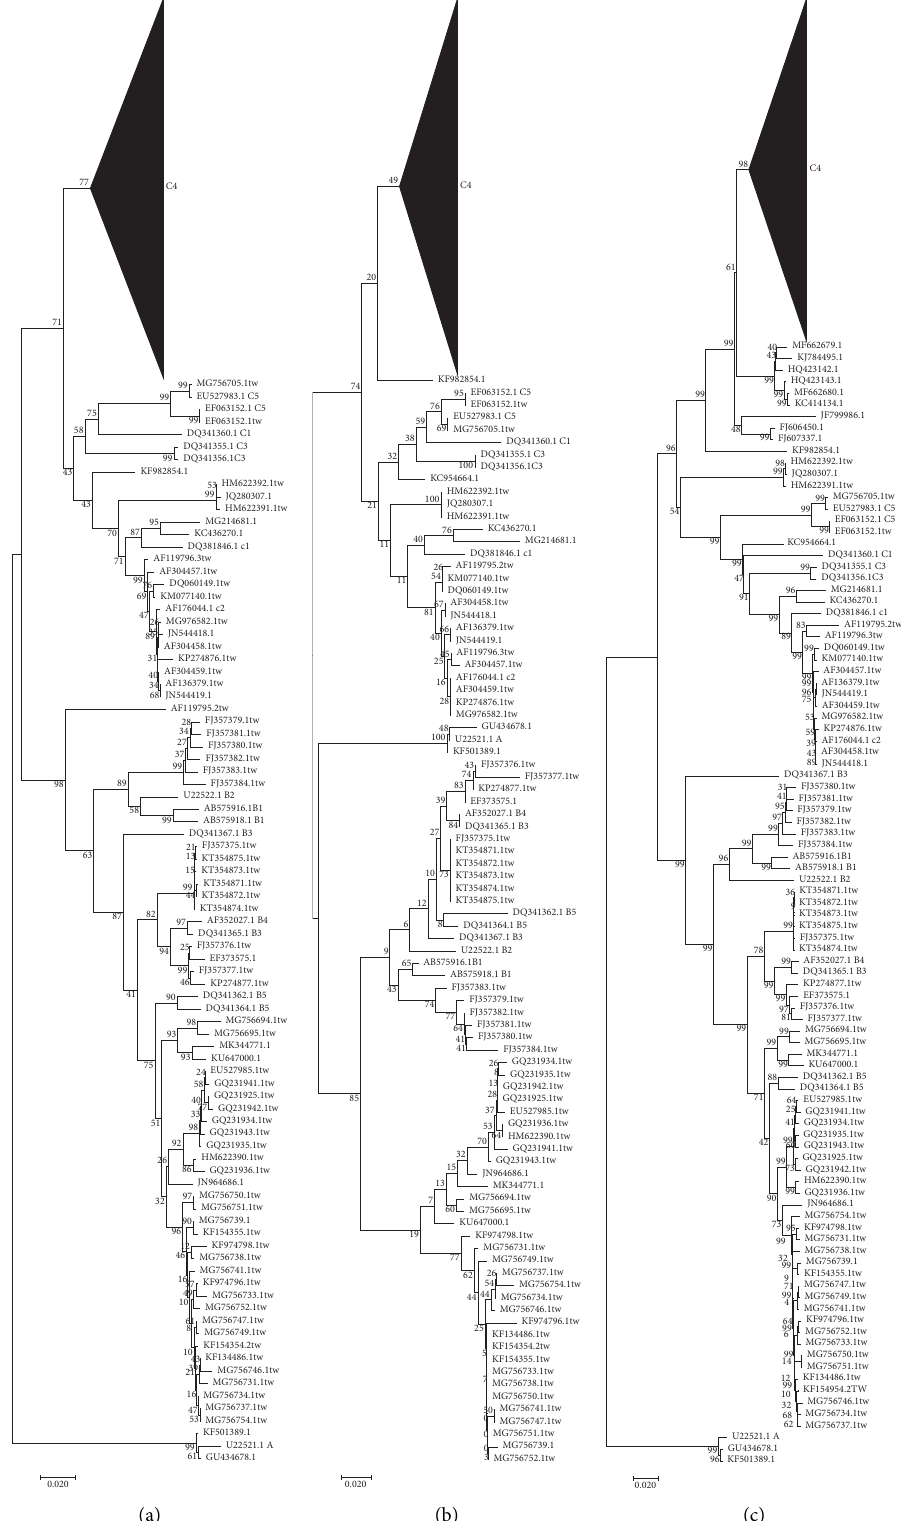
Figure 4: Phylogenetic trees constructed with the VP1, VP4, 2C, 3C, 3D, and whole-genome sequences of EV-A71. (a) VP1 phylogenetic tree; (b) VP4 phylogenetic tree; (c) whole genomes phylogenetic tree. The C4 subtree was compressed. Each strain is named according to the GenBank accession number. Taiwan’s strains have a TW suffix, and the reference strains have corresponding subtype name